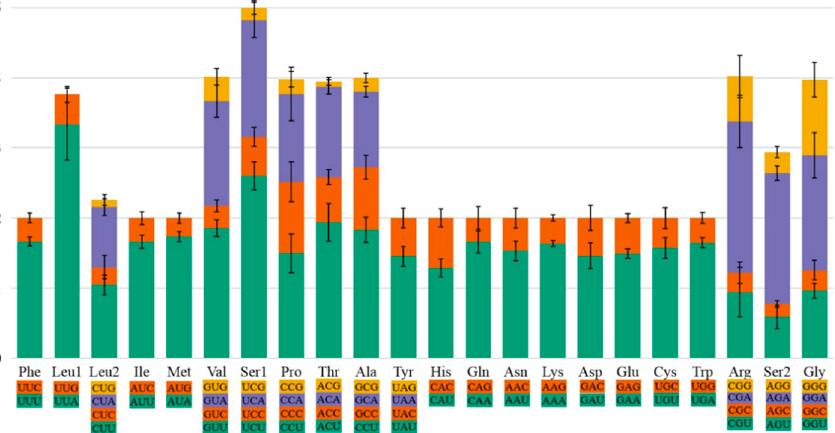
Figure 2. The relative synonymous codon usage (RSCU) of the protein-coding genes of the mitogenome in eight bark beetles. Codon families are indicated on the x -axis and RSCU values on the y -axis. The error bars represent the standard error. Table 2. Comparison of tRNA secondary structure mismatches in eight bark